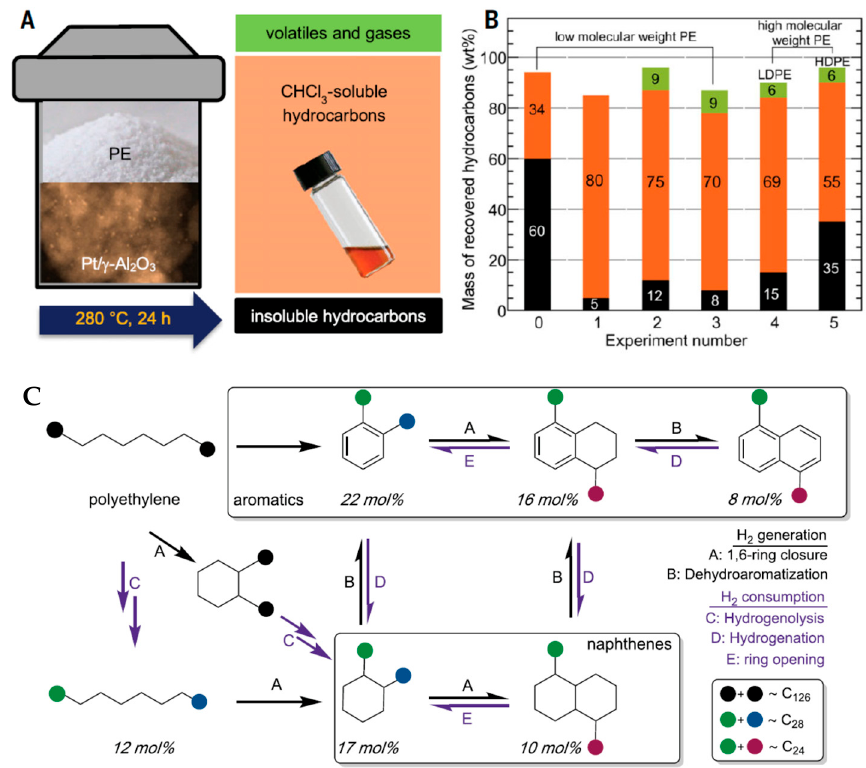
Figure 5. ( A ) Schematic of reactor and product fractions with photographs of the powdered polymer and liquid products, as well as a transmission electron micrograph of the catalyst. ( B ) Hydrocarbon distribution after 24 h at 280 °C. ( C ) Overall PE conversion to alkylaromatics and alkylnaphthenes, and proposed mechanism of tandem polyethylene hydrogenolysis–aromatization via dehydrocyclization [110].